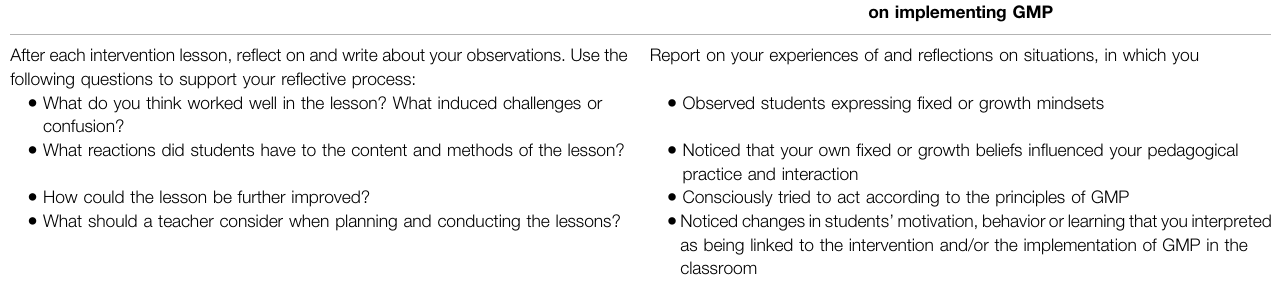
TABLE 2 | Re fl ection instructions. Guidelines for re fl ections during the student intervention Guidelines for re fl ections